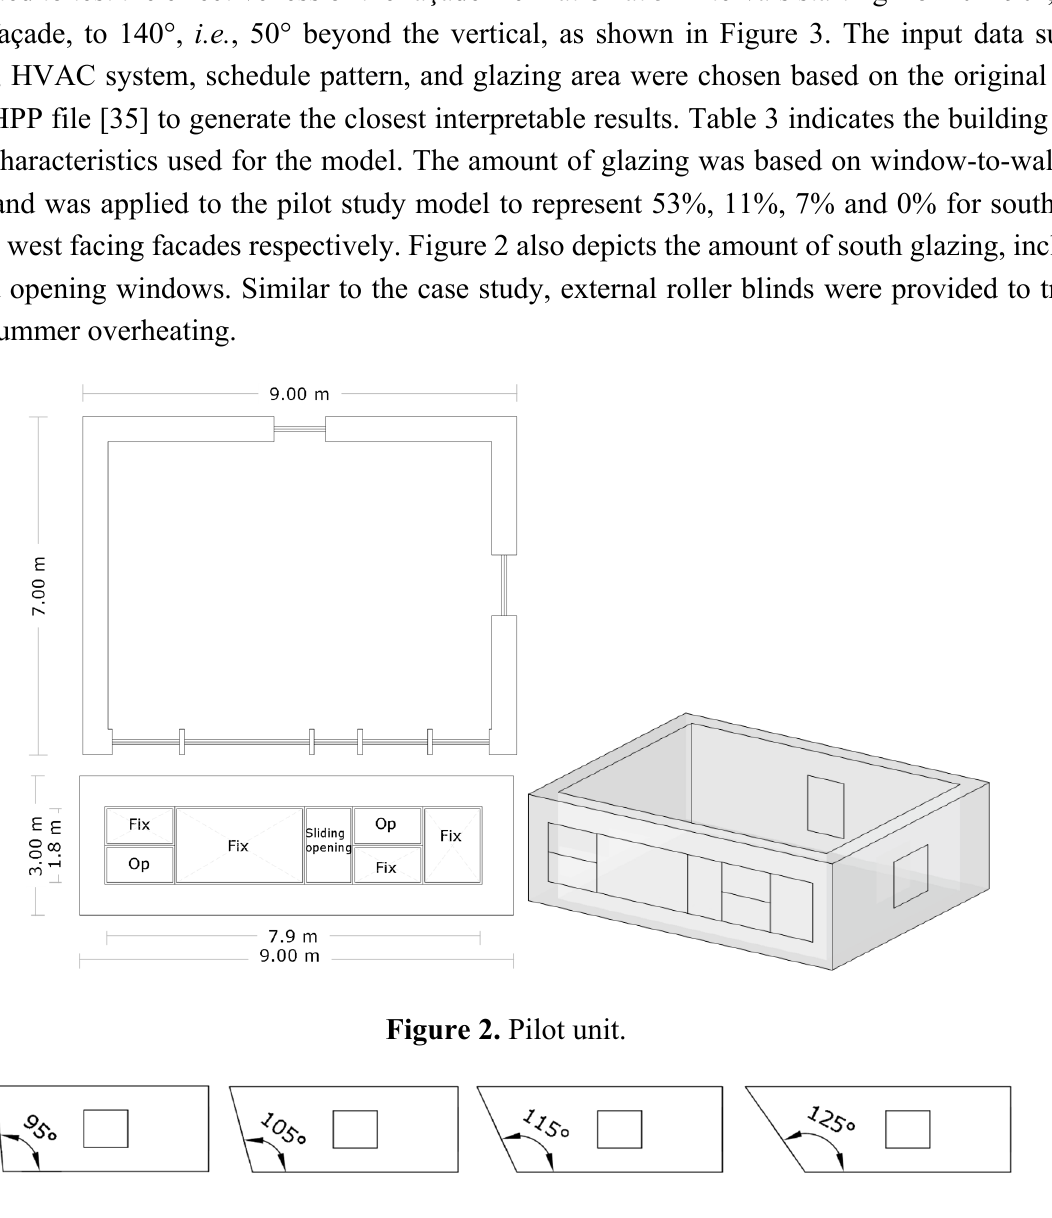
Figure 3. Side elevation of different façade